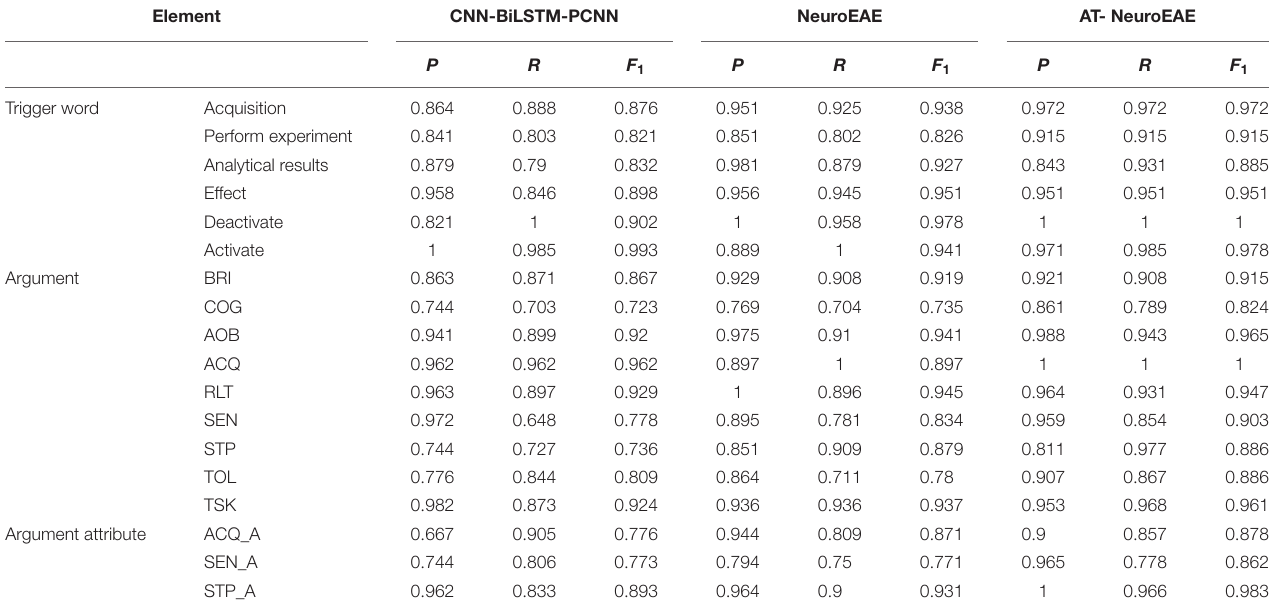
TABLE 9 | Event element